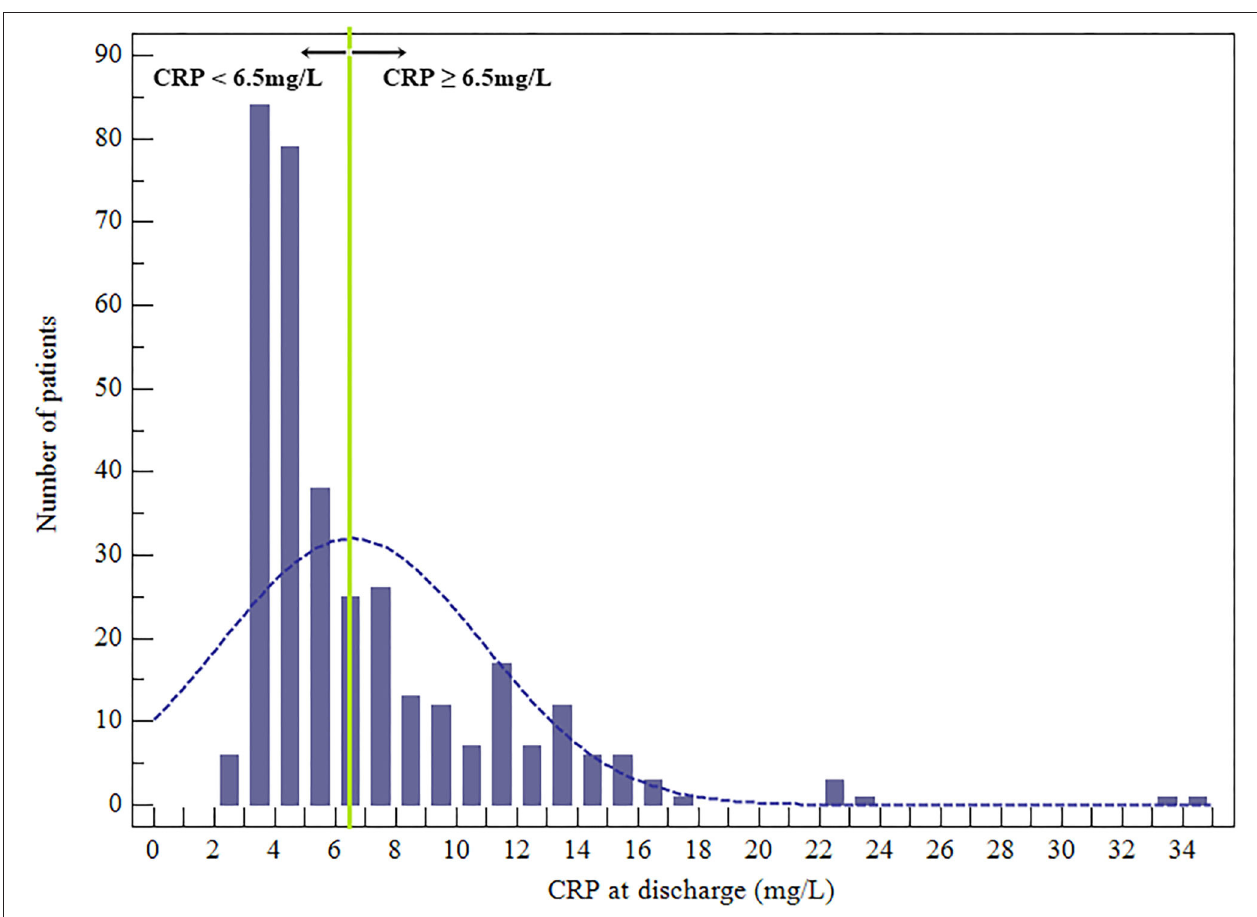
FIGURE 2 | Distribution of the CRP values at hospital